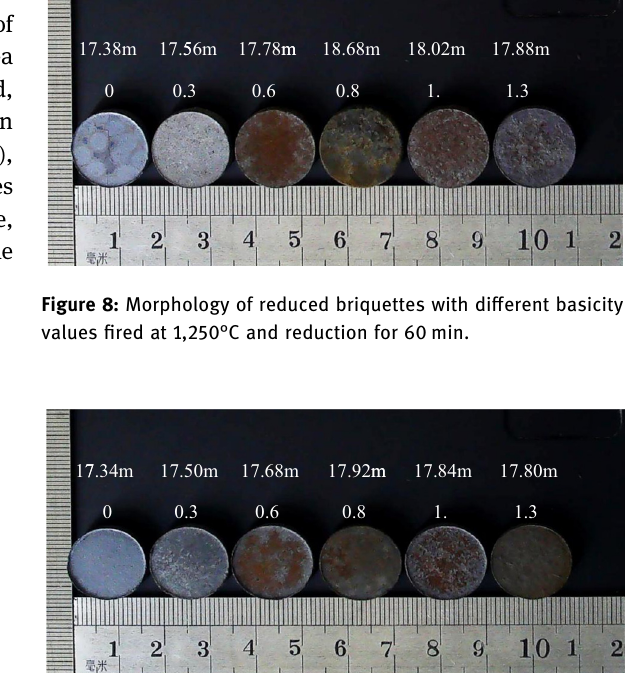
Figure 6: E ff ects ofbasicity on the reducibility degreeof the briquettes.